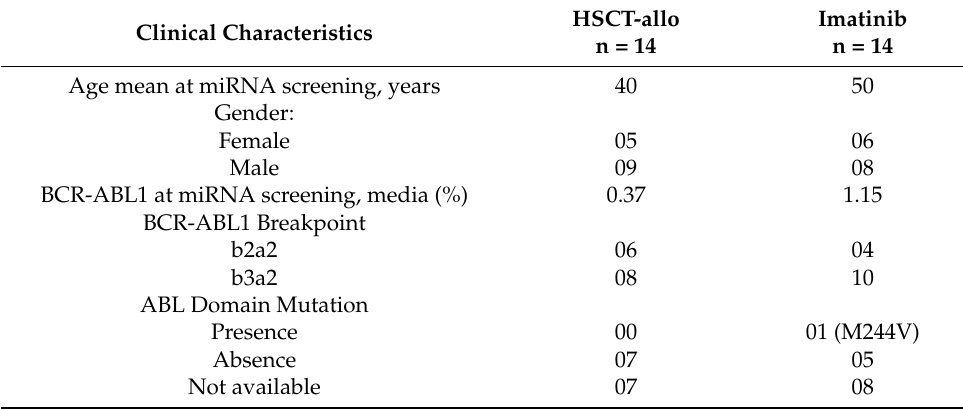
Table 4. Patients’ clinical